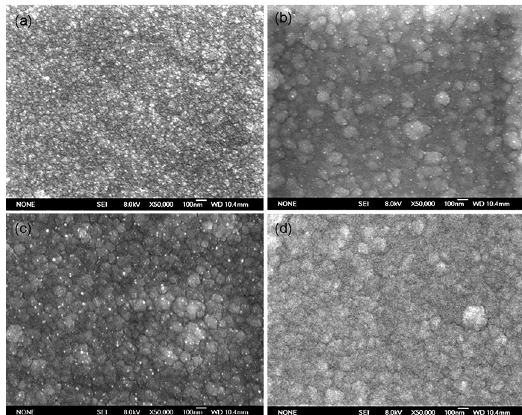
Figure 5: FESEM morphology of the coatings at different times under 100W plasma power. (a) 10 minutes, (b) 20 minutes, (c) 40 minutes, (d) 60 minutes.